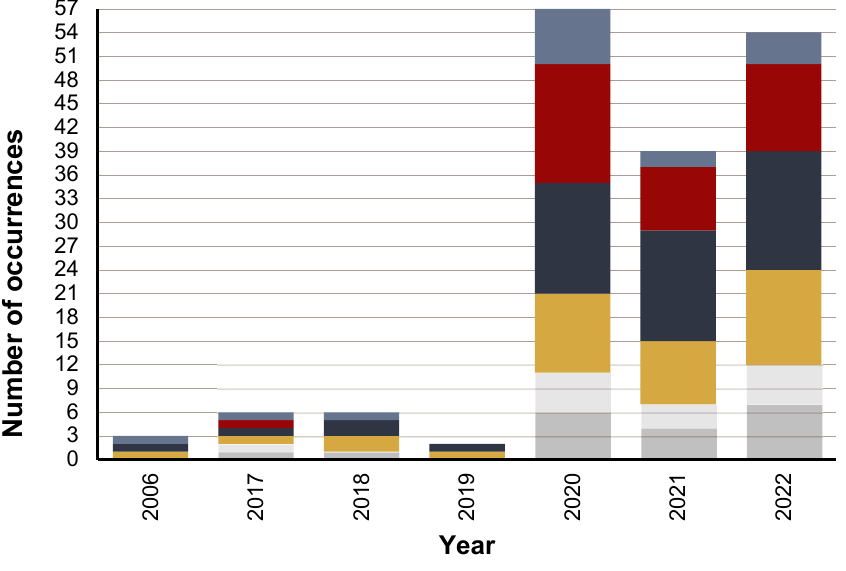
Figure 3. The intensity of the reviewed literature per research dimension.